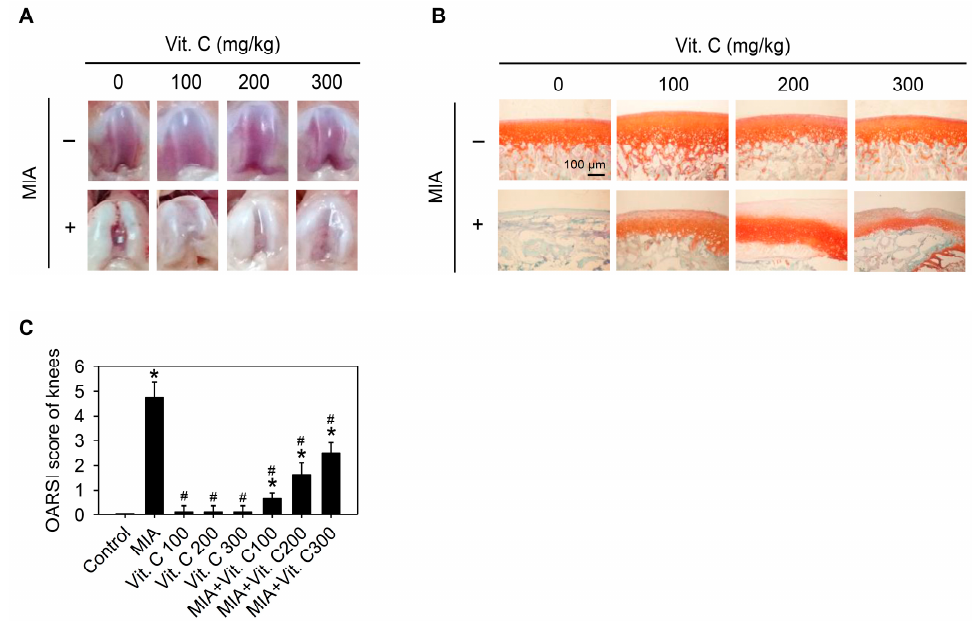
Figure 8. Effect of vitamin C on articular cartilage of rat with MIA-induced OA. The details of MIA-induced OA in rats and subsequent vitamin C treatment are described in the Materials and Methods. After vitamin C treatment for two weeks, the articular cartilage of rats was removed and ( A ) macroscopic observation or ( B ) histologic evaluation or ( C ) Osteoarthritis Research Society International (OARSI) score of each joint occurred, n = 10. * p < 0.05 compared to the untreated control. # p < 0.05 compared to the MIA treated group.